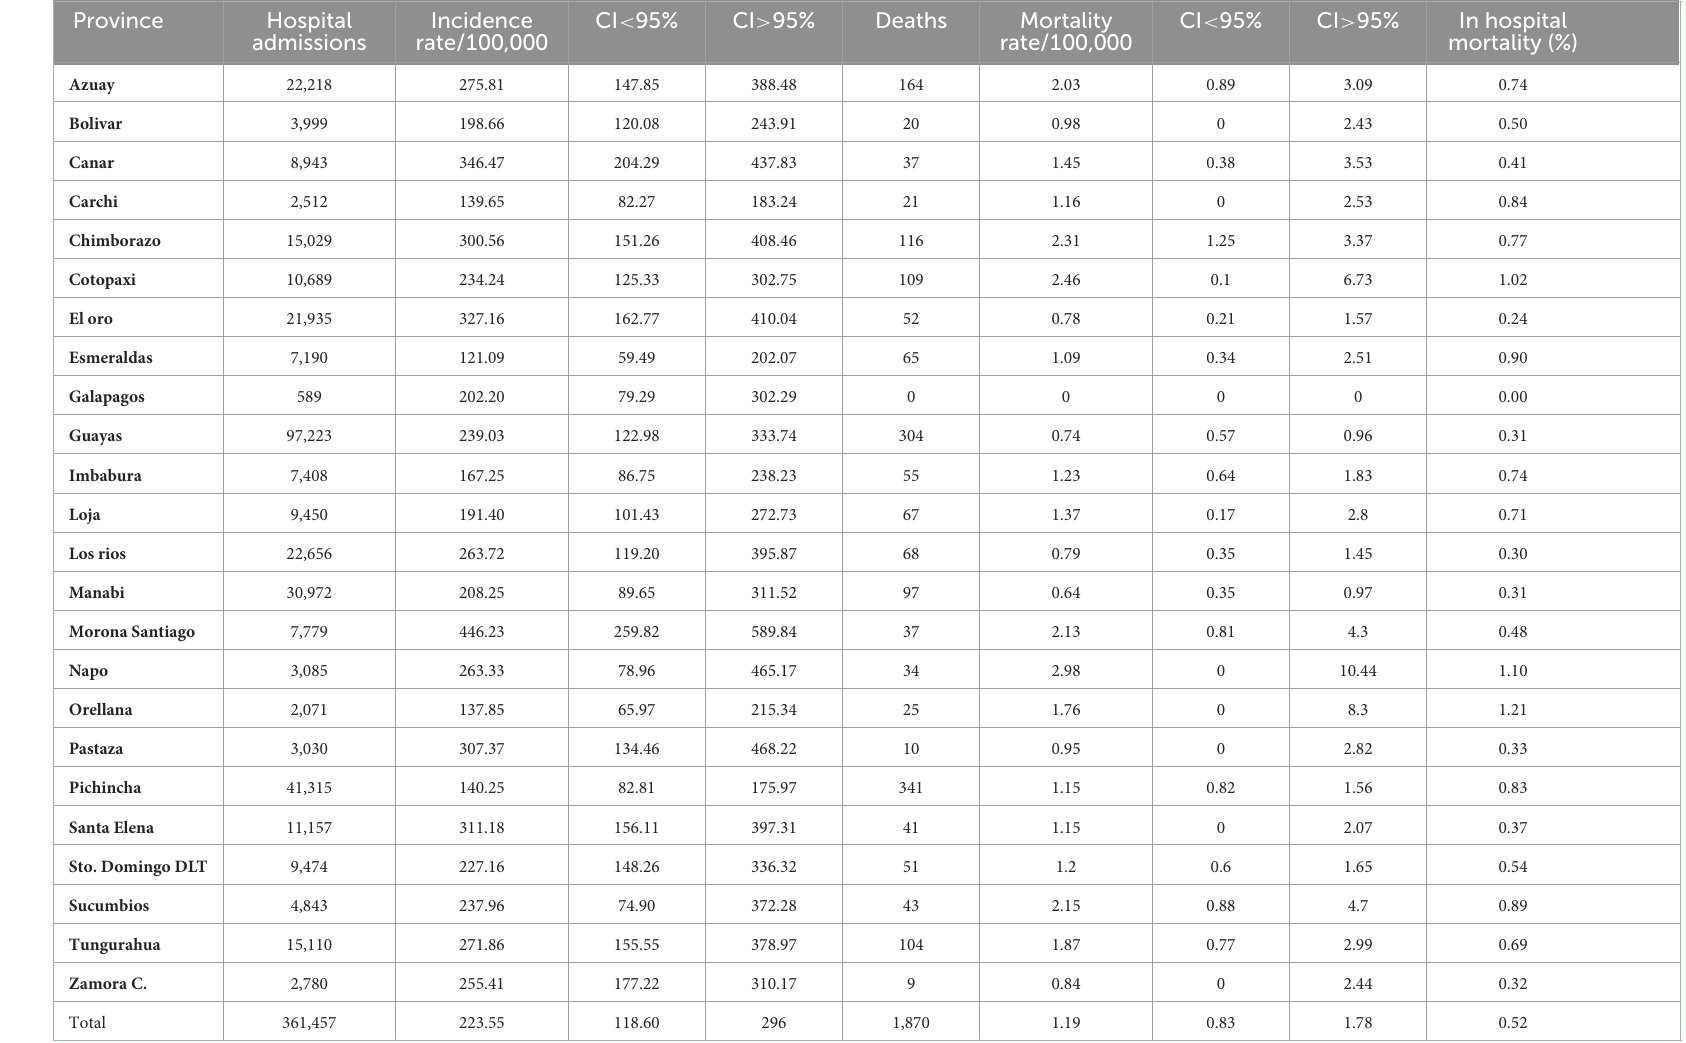
TABLE 6 Incidence and mortality rate due to waterborne diseases by province in Ecuador from 2011 to 2020. Province Hospital